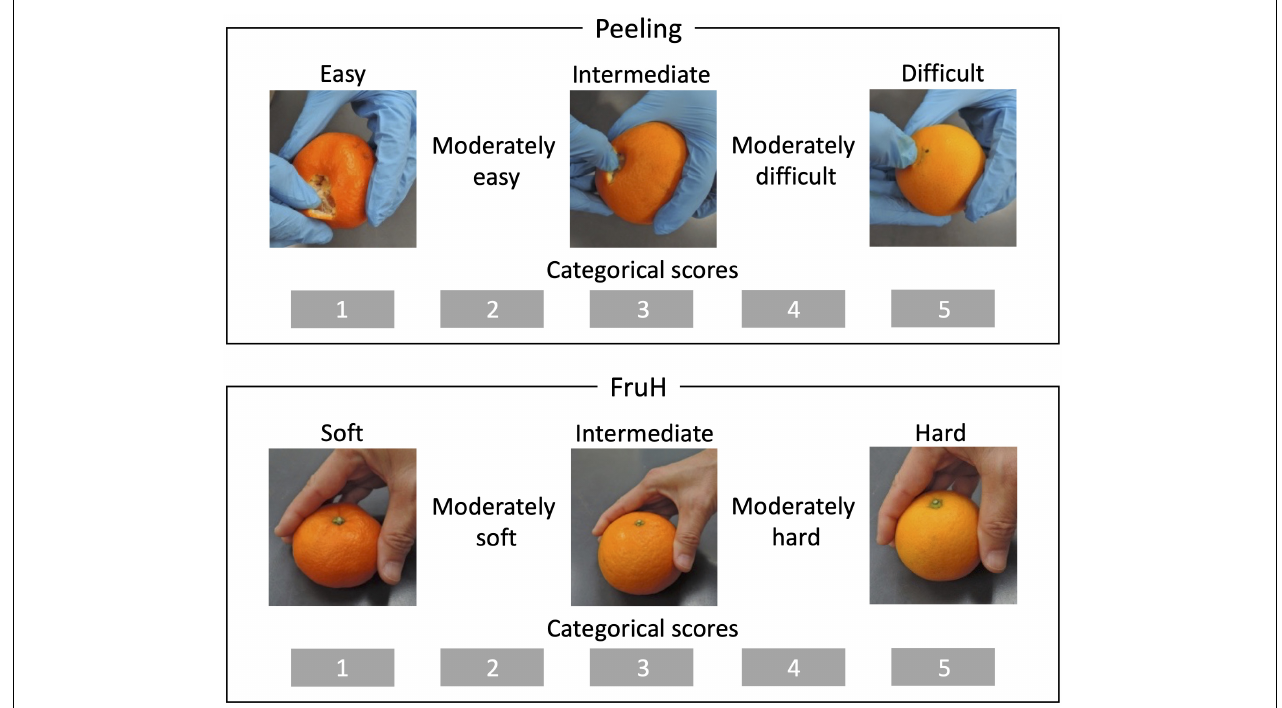
FIGURE 1 | Breeder-evaluated fruit quality traits. Peeling and FruH indicate the easiness of peeling and fruit hardness, respectively. Both the traits were sensorily and qualitatively evaluated by a small number of professional breeders.